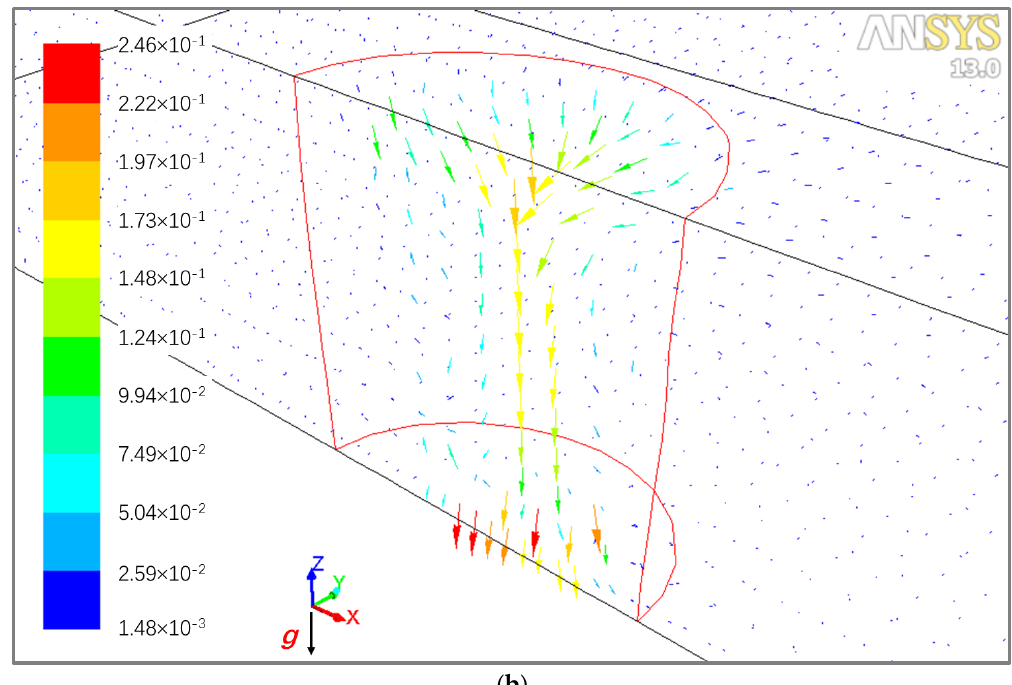
Figure 8. Velocity fields in the weld pool for flat welding (unit: m/s): ( a ) whole model; and ( b ) magnified melt pool region.